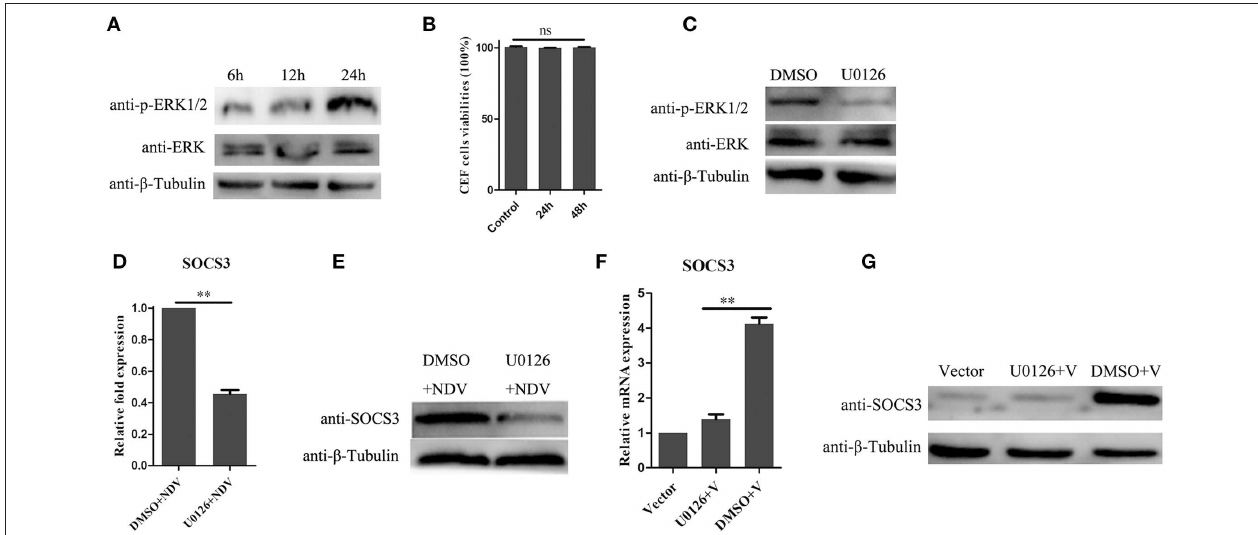
FIGURE 6 | MEK/ERK signaling pathway is involved in the expression of SOCS3. (A) phosphorylated ERK1/2 was detected after NDV (0.1 MOI) infection at different time. (B) CEF cells were treated with 20 µ M of the ERK 1/2 inhibitor U0126 or DMSO for 24 and 48h, and CCK-8 assay was performed to analyze the cytotoxicity of U0126 (20 µ M) to CEF cells. CEF cells were treated with 20 µ M of the ERK 1/2 inhibitor U0126 or DMSO for 12h and infected with NDV (0.1 MOI). Cells were harvested at 24 hpi. Phosphorylated ERK1/2 was detected by WB (C) , and qRT-PCR (D) and WB (E) were used to detect the expression of SOCS3. (F,G) CEF cells were treated with 20 µ M of the ERK 1/2 inhibitor U0126 or DMSO for 12h and then transfected with a pCAGGS-V-Flag (V) expression plasmid or pCAGGS-Flag (Vector). Cells were harvested 24h post transfection. qRT-PCR (F) and WB (G) were used to detect the expression of SOCS3. Data presented are from three independent experiments and presented as mean ± SD. ** P <